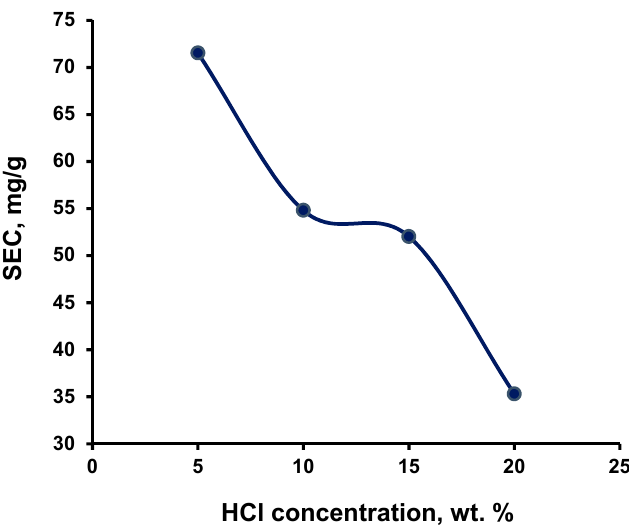
Figure 6. Dependence of Purolite A-100 ion-exchange resin on hydrochloric acid concentration.